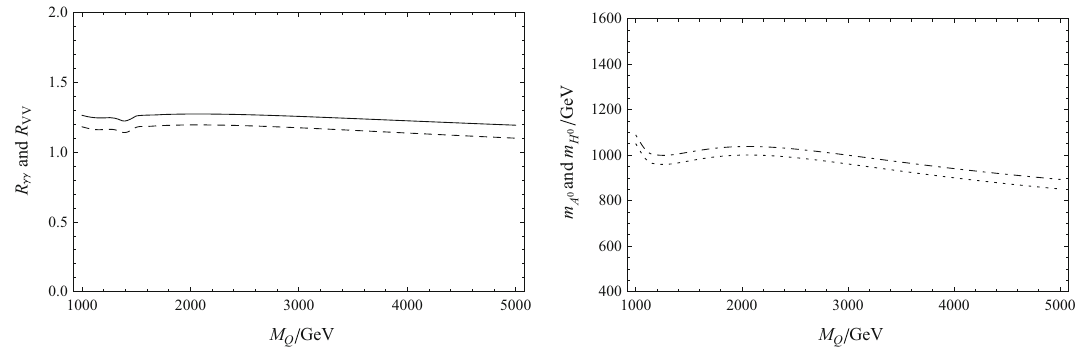
Fig. 4 The results versus M Q are shown. R γγ (solid line) and R VV (dashed line) are in the left diagram. m A 0 (dot-dashed line) and m H 0 (dotted line) are in the right diagram